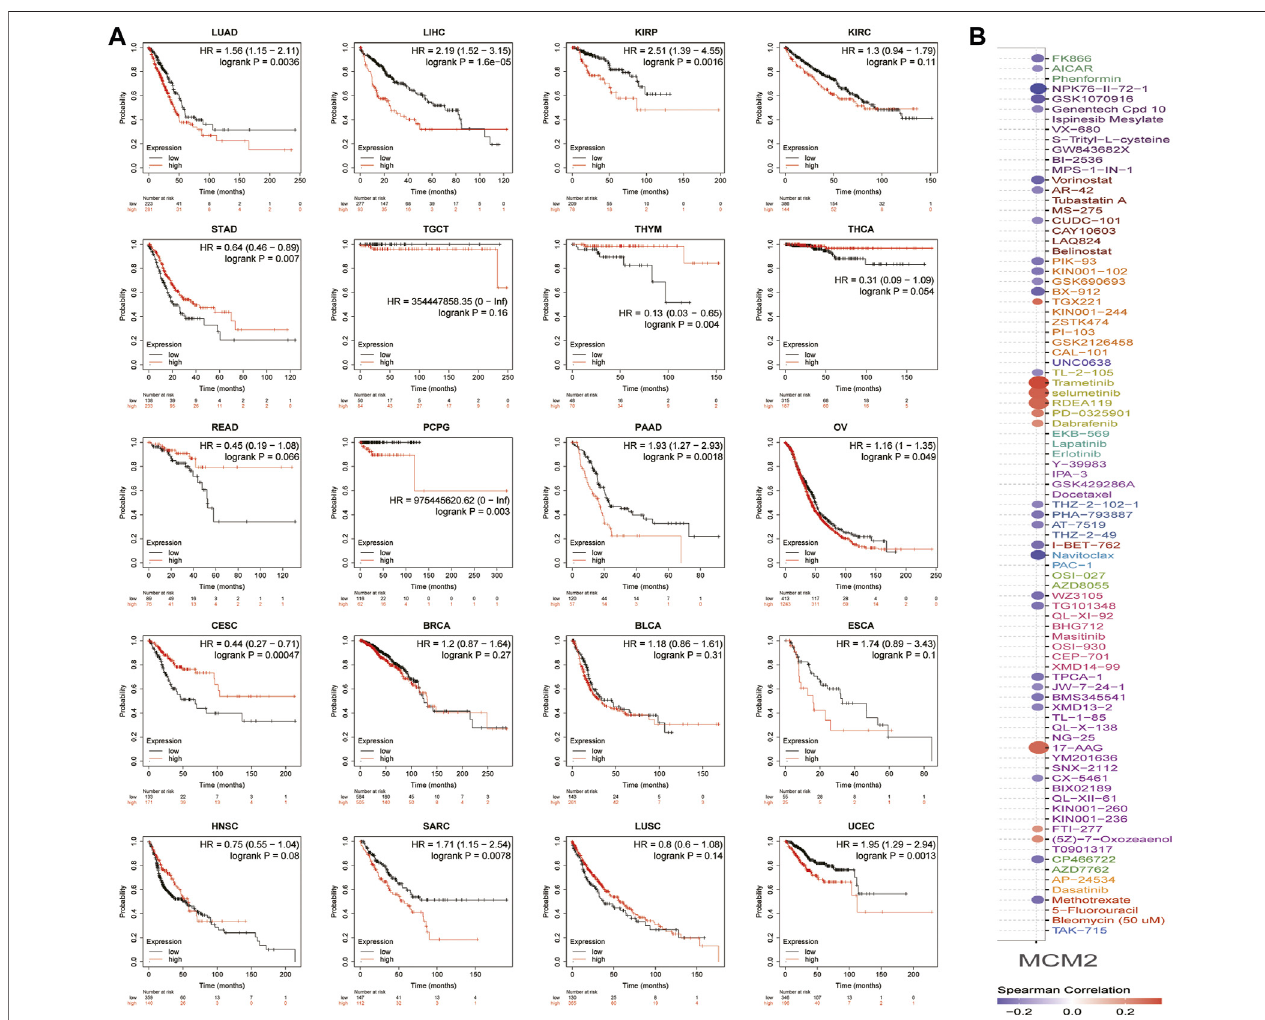
FIGURE9| TheclinicalvalueofMCM2invariouscancers. (A) OSofpatientswithdifferentexpressionlevelsofMCM2inpan-cancerfromtheKaplan – MeierPlotter database. (B) The relationship between MCM2 expression level and sensitivity to different drugs. The colors indicated the correlation between MCM2 expression and drugsensitivity.Redindicatedpositiverelationship, whilepurplenegative.Thesizeofthespotsindicatedthesigni fi canceofthecorrelation.Thebiggerthesize,themore signi fi cant correlation.